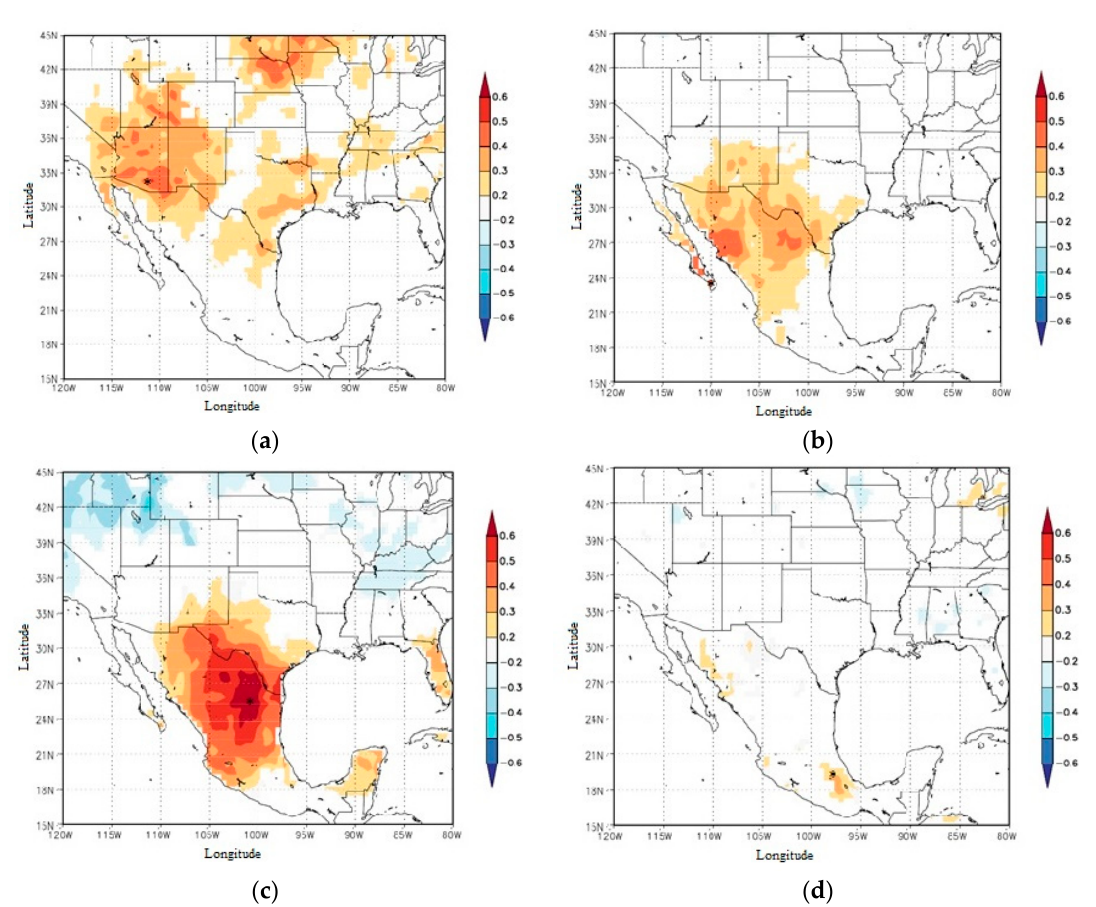
Figure 5. Spatial correlations calculated with the residual chronologies of ring-width indices at each site and the most significant growth—Standardized Precipitation Evapotranspiration Index (SPEI) correlations of each site obtained at eight-Arizona ( a ), eight-California Sur ( b ), six-Nuevo León ( c ), and 12-month long scales Puebla ( d ). The asterisk indicates the approximate location of each study area.